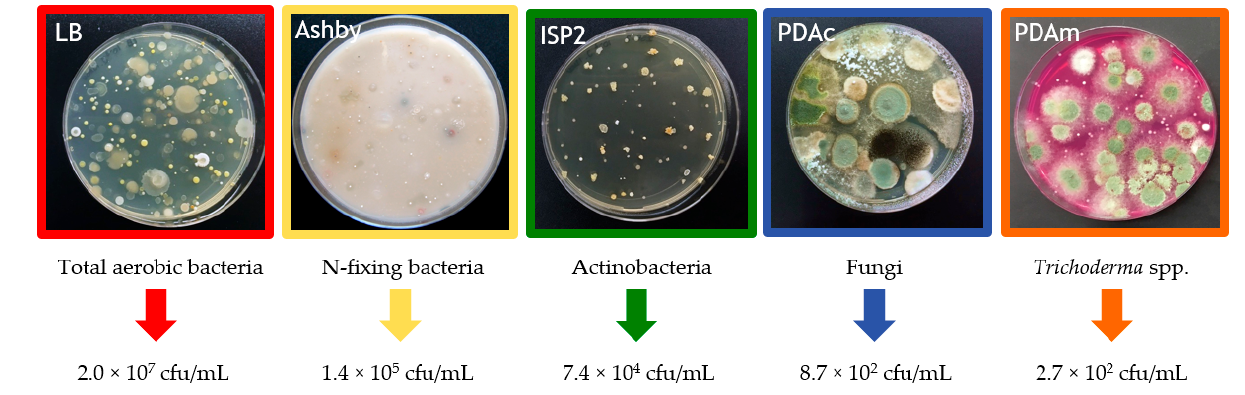
Figure 2. Microbial populations in green waste compost tea.